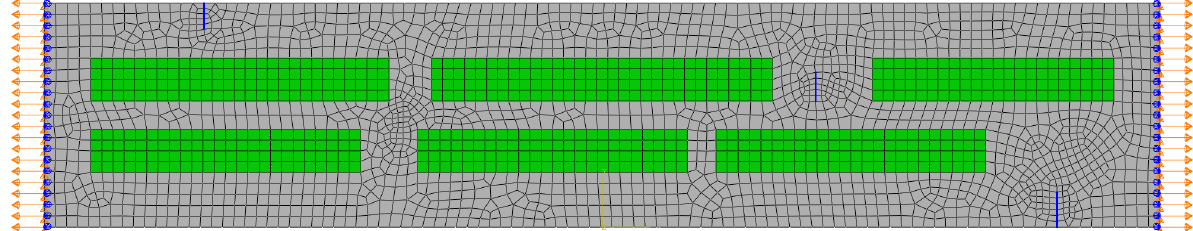
Figure 10: The 2D FEM model of the outer region of the cortical bone. The interstitial bone is coloured to gray, the lamellae is coloured to yellow, and the blue line marked out the